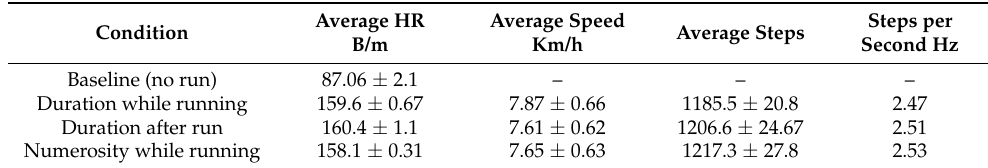
Table 1. Descriptive statistics of running parameters.